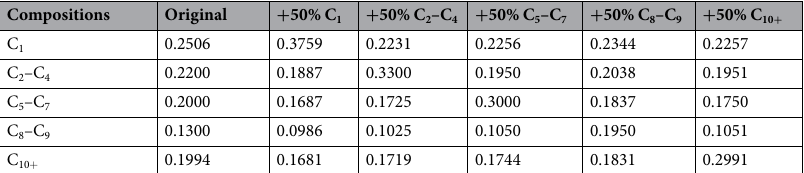
Table 2. The original and altered compositions of the Bakken fluid.